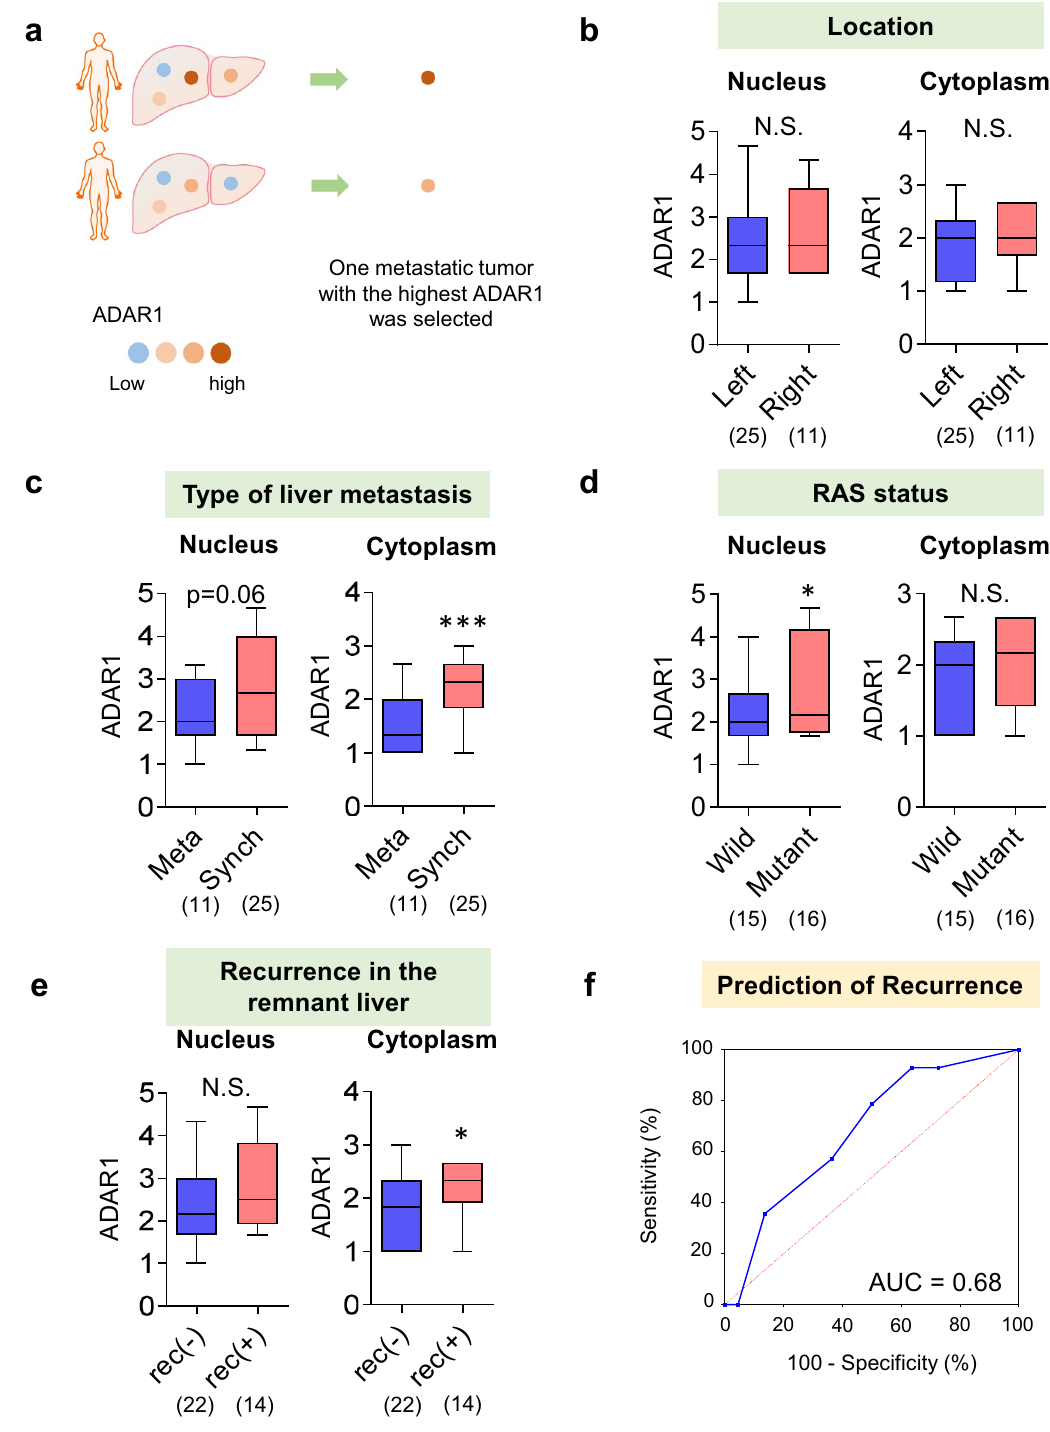
Figure 3. ADAR1 expression in each representative metastatic site in each patient. ( a ) One liver metastasis with the highest ADAR1 staining intensity was selected among liver metastases. ( b–e ) The ADAR1 expression was upregulated in patients with liver metastases from concurrent liver metastases, RAS mutant-type cancer, and remnant liver recurrence. ( f ) A high ADAR1 expression was a predictive factor of remnant liver recurrence (area under the curve = 0.68). *p < 0.05, ***p <